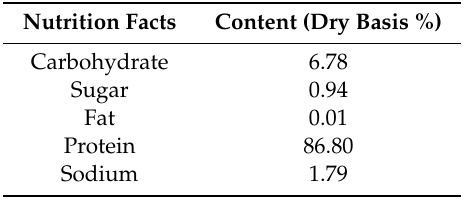
Table 1. Nutrient composition of the silk peptide.